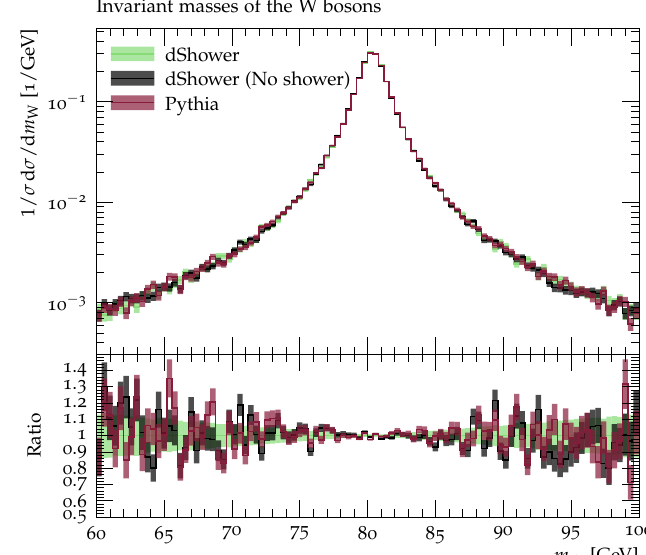
Figure 10 . Mass spectrum of the W bosons. This histogram has been made by recording the values of the masses of the two W bosons produced in each